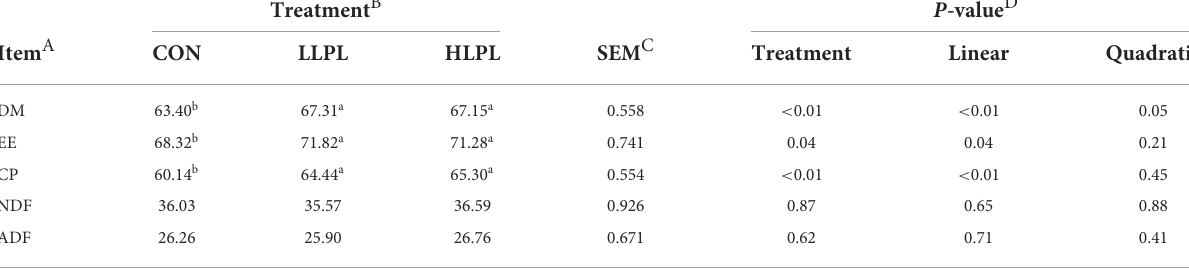
TABLE 3 Effect of dietary lysophospholipids supplementation on nutrient digestibility of beef